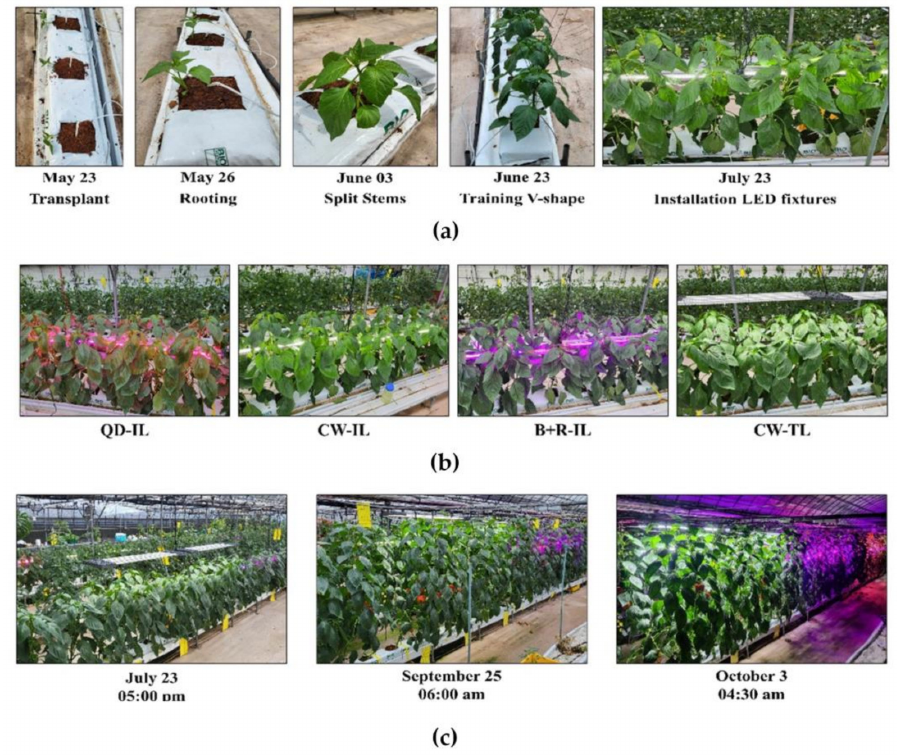
Figure 7. Representative images taken during cultivation. ( a ) Cultivation overview and LED instal- lation. ( b ) Supplemental lighting images for each of the LED treatments: QD-IL, QD inter-lighting; CW-IL, cool-white inter-lighting; B+R-IL, blue + red inter-lighting; CW-TL, cool-white top-lighting. ( c ) View of cultivation sites by period during supplemental lighting